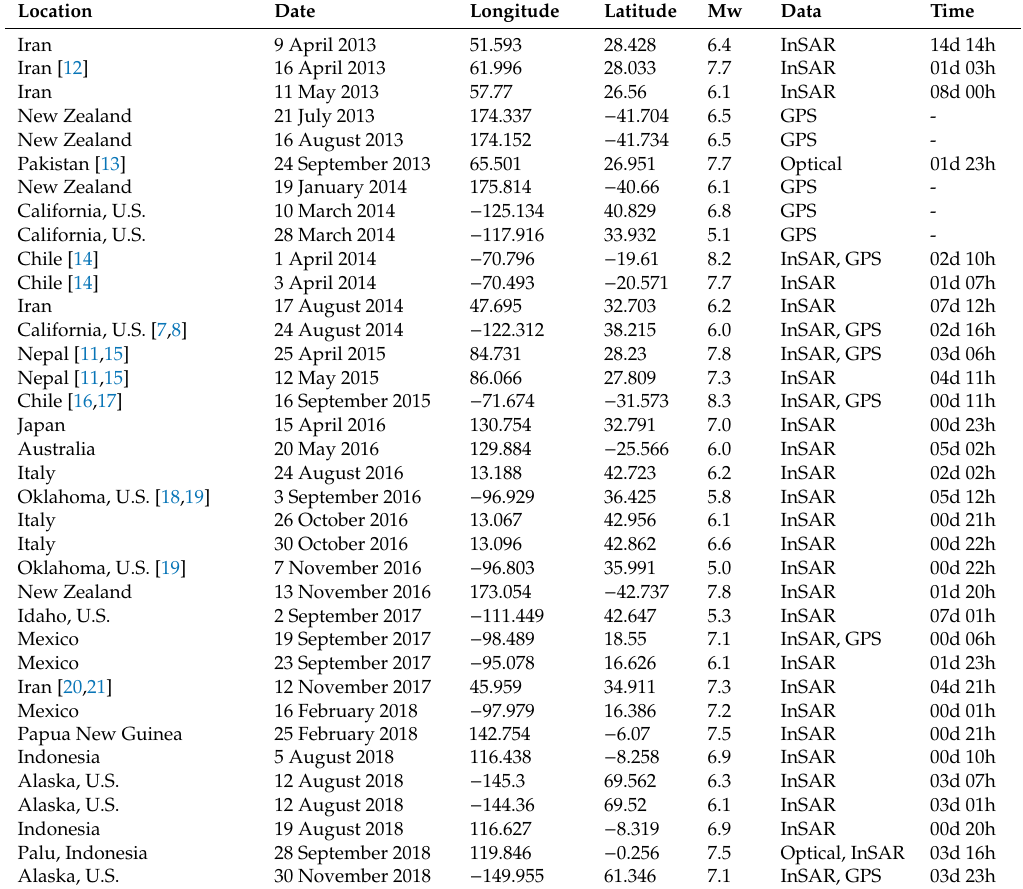
Table 1. List of earthquakes for which geodetic observations were used in some capacity during NEIC earthquake response e ff orts. Locations of events are denoted by their origin country or state within the United States, longitude, and latitude, and shown in Figure 1. Data type indicates the type of geodetic observations used in constraining the events for response purposes. Time indicates the time, in days (d) and hours (h), that the first usable remote sensing image (SAR or optical) was acquired after origin time. In all cases where GPS observations were used, GPS displacements / time series were available within 24 h of origin time. Indices indicate publications that include scientific results from the response e ff orts and descriptions of the data sets used. In many instances, geodetic products only provided independent verification of seismically-determined